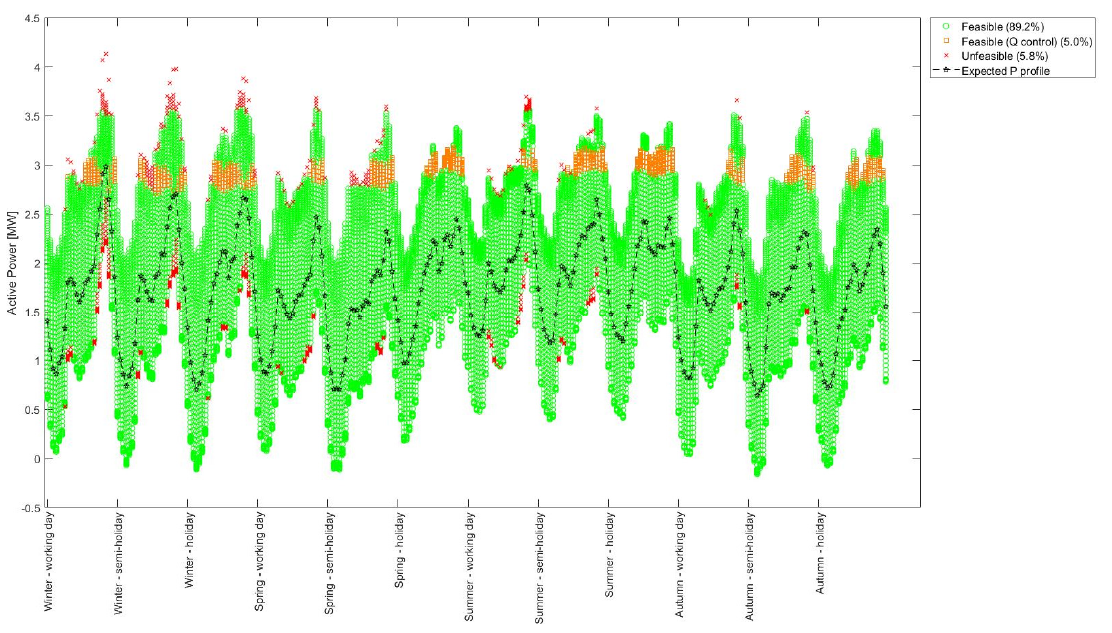
Figure 8. Potential profile during all representative days, feeder R2—case B (“DG + end-users”). Only the single feeders have been discussed regarding the flexibility until this point.